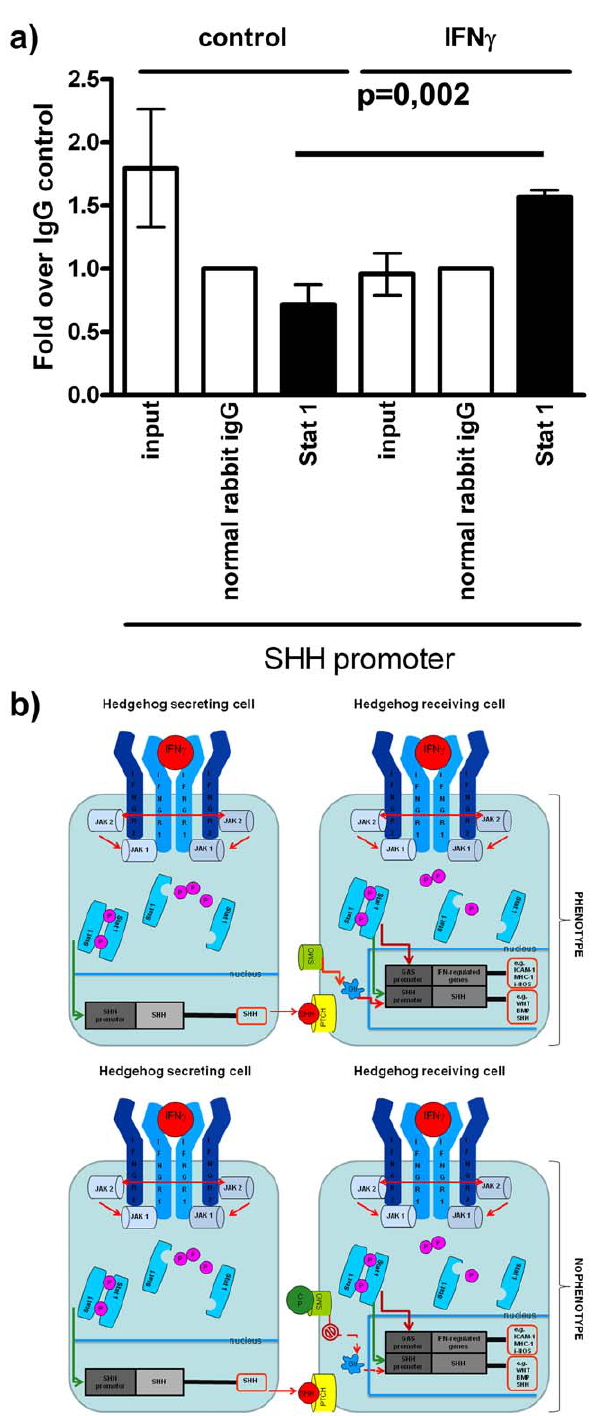
Figure 4. The mechanism of IFN c -mediated dysregulation of NSPCs. In Figure 4a: The results of the chromatin immunoprecipitation of the SHH promoter region with a Stat 1 antibody are shown. In Figure 4b: A schematic drawing of potential pathways that might be involved in IFN c -induced NSPC dysregulation. CP: Cyclopamine, SMO: smoothened, PTCH: patched, GAS: interferon- gamma - activated site (GAS), ICAM-1: intercellular adhesion molecule 1, MHC-1: major histocompatibility complex 1, i-NOS: inducible nitric oxide synthase, JAK2: janus kinase 2, Stat 1: signal transducers and activators of transcription